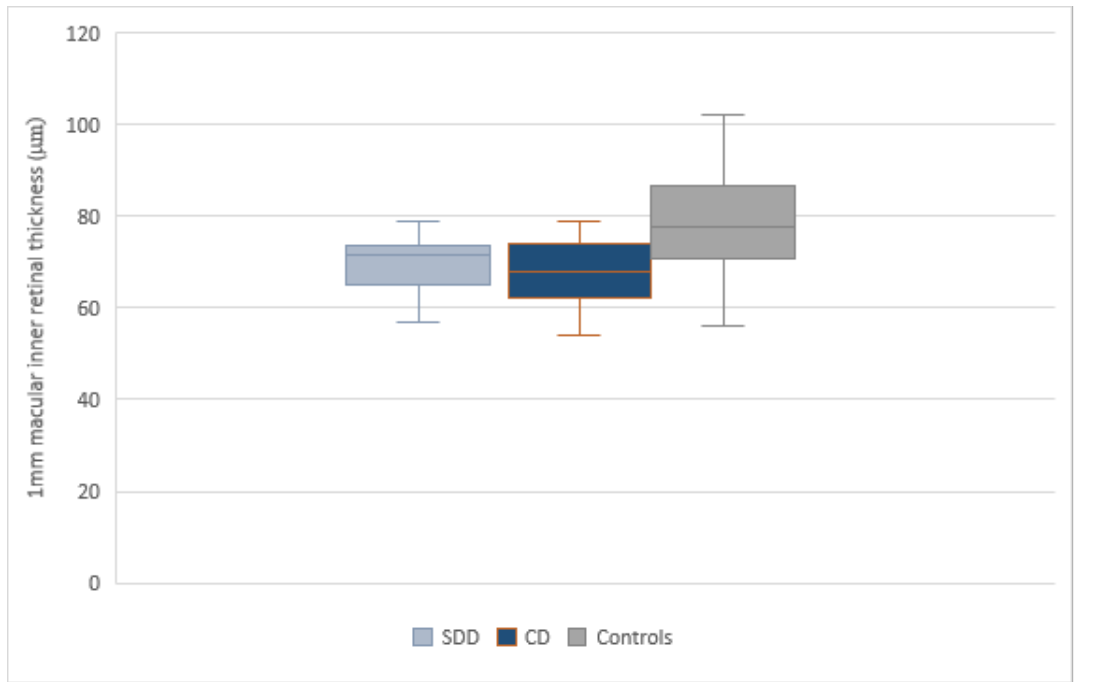
a: Comparison of eyes with SDD a Comparison of eyes with SDD versus eyes with CD. b: Comparison of eyes with SDD, eyes with CD, and control group eyes (control group). c: Post hoc Tukey HSD, multiple comparison between groups. d: ANCOVA, adjusted for age. e: Comparison of eyes with SDD and control group eyes (control group). f: Comparison of eyes with CD and control group eyes (control group). *Statistically significant ( p < 0.05).